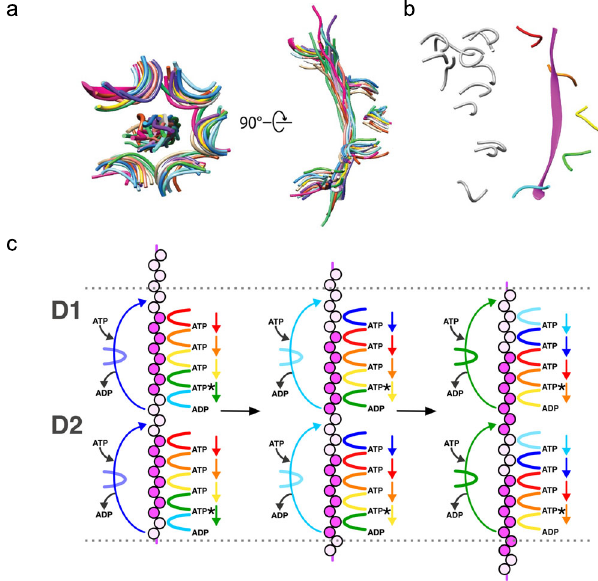
Fig. 4 Substrate translocation model. a p97 D2 pore loops (light purple) of subunits A-E superimposed with the equivalent residues from 14 AAA ATPases, including YME1 (PDB 6AZ0, tan) 12 , Vps4 (6AP1, light blue) 14 , D1 of p97 (this study, gray), Spastin (6PEN, pink) 20 , TRIP13 (6F0X, magenta) 49 , Msp1 (6PE0, yellow) 50 , Katanin (6UGE, dark blue) 51 , D1 and D2 of Cdc48 (6OPC, dark purple and purple, respectively) 18 , Hsp104 (5VJH, dark green) 52 , human 19 S regulatory particle (6MSE, turquoise) 53 , yeast 19S regulatory particle (6EF3, brown) 54 , Rix7 (6MAT, green) 55 , and Abo1 (6JQ0, light green) 56 . b p97 D2 pore loops 1 (subunits A – E) and substrate displayed in colors. Subunit F pore loop 1 from the various AAA unfoldase structures shown in panel a displayed in gray. c Hand-over-hand translocation model. A strand of unfolding substrate (circles) is threaded through the central pore of the p97 hexamer. Adjacent pore loops (right arcs) form grooves that bind dipeptides of the unfolding substrate. ATP binding stabilizes the intersubunit interface of peptide-binding subunits. ATP hydrolysis and phosphate release (asterisks) weakens the interface and peptide binding. The sixth subunit (left arc) detaches from bottom of each hexamer stack. Nucleotide exchange and ATP binding to the detached subunit promotes its re-engagement to the next exposed dipeptide of the unfolding substrate and re-stabilizes the intersubunit interface. Colored arrows indicate directionality of movement for each subunit. The process repeats with the detachment of the bottom-most subunit and its re-binding at the top of each hexamer (Supplementary Fig. 1C, Supplementary Table 2). The presence of K6, K11, and K63 linkages were also detected, which suggests that p47 interacts with diverse ubiquitin chains. These fi ndings are consistent with the model that substrate density in our recon- struction corresponds to the superposition of multiple different substrate proteins.